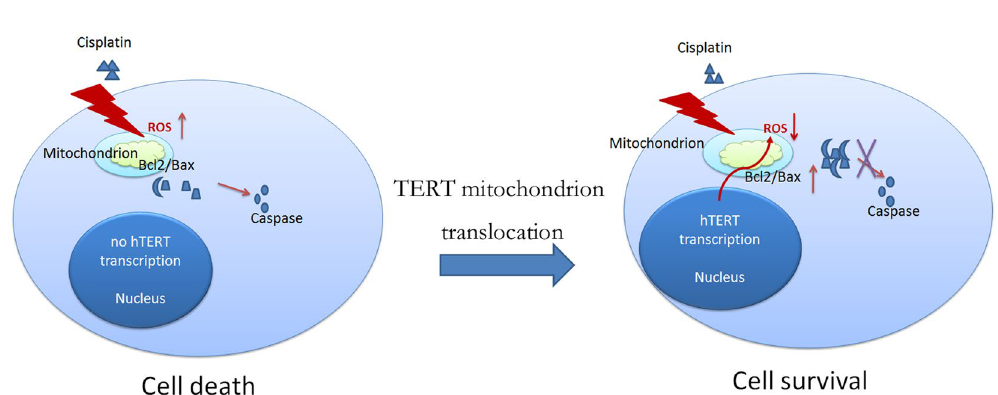
Figure 6. Underlying mechanism of TERT-mediated protection against cisplatin-induced osteosarcoma cell death. In cisplatin sensitive osteosarcoma cells, TERT doesn’t shuttles from the nucleus to mitochondrion upon cisplatin treatment, which results elevated intracellular ROS levels. Increased ROS levels further activates mitochondrial apoptotic pathway and causes programmed cell death. In cisplatin-resistant osteosarcoma cells, TERT shuttles from the nucleus to mitochondrion and alleviates intracellular ROS levels upon cisplatin treatment, which results inhibited mitochondrial apoptosis and cell